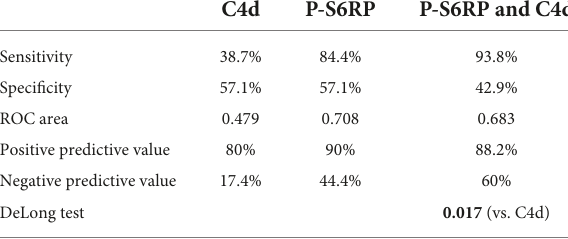
TABLE 7 Diagnostic capability of C4d, p-S6RP, and p-S6RP&C4d to distinguish DSA + from DSA − in cases with ABMR + . C4d